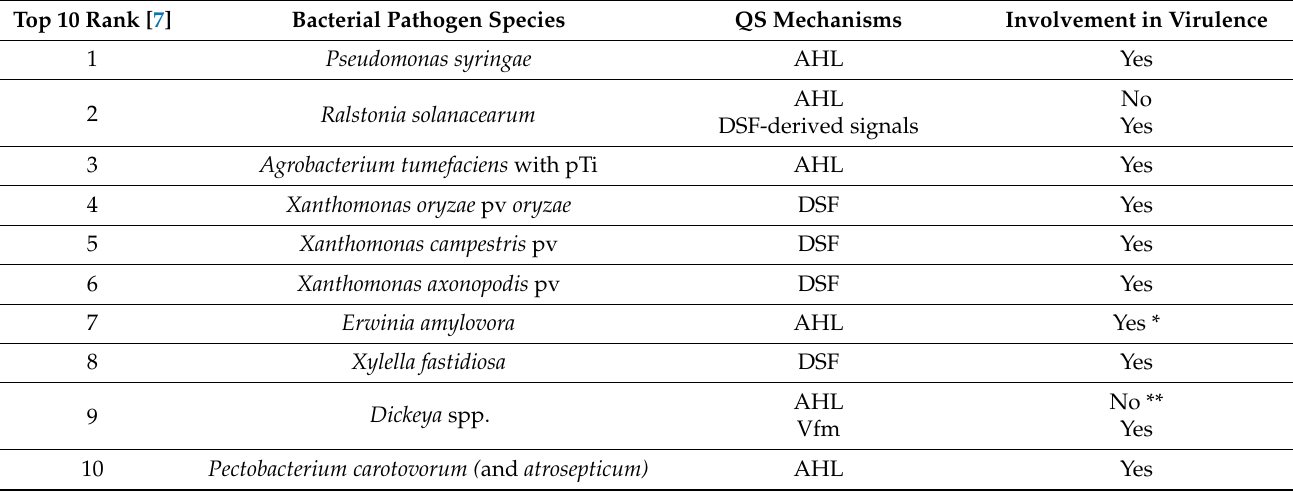
Table 1. Quorum screening (QS) systems present in bacterial plant pathogen species. The table presents a ranked list of the bacteria according to Mansfield et